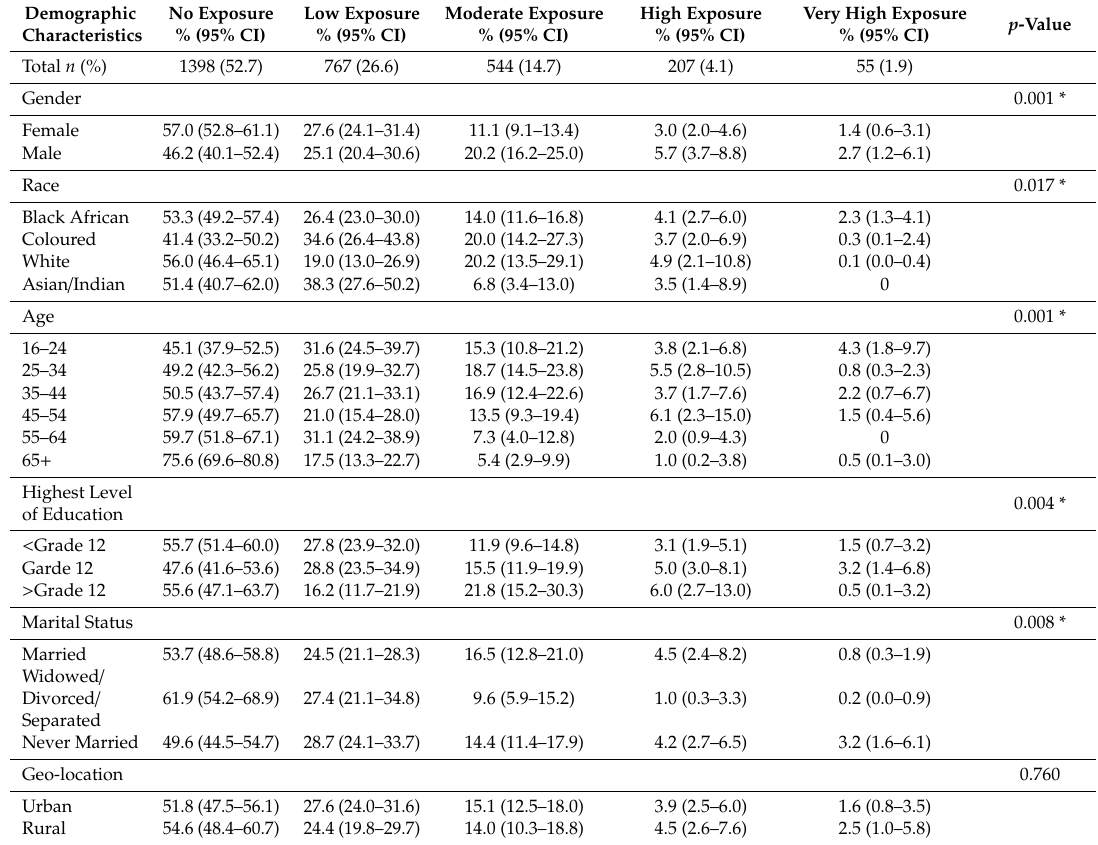
Table 3. Non-smokers’ level of exposure to SHS by demographics.